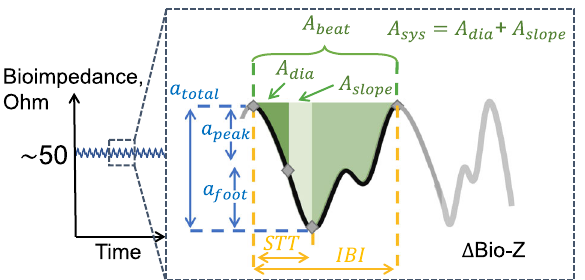
Fig. 4 Bioimpedance signal illustration during a cardiac cycle and the corresponding bioimpedance feature de fi nitions used in blood pressure correlation analysis. The amplitude features are shown in blue color, the timing features are shown in yellow color (STT: slope transit time, IBI: inter-beat intervals), and the area features are shown in green color. We named the feature pertaining to the area between the diastolic point and the maximum slope point as A dia , the area between the maximum slope point and the systolic point as A slope , and the area between the diastolic and the systolic point as A sys performance, and to avoid additional burden on the participants), while all fi ve participants underwent the test involving different separations. During the experiments, the participants were asked to remain still with their left hand resting on a table, as shown in Fig. 3d. For each ring setup a total of fi ve 30-second trials were conducted and the data is post-processed in MATLAB R2019b for sensitivity and signal fi delity analyses. To assess the ring sensor sensitivity to digital artery blood fl ow, we analyzed the quasi-periodic bioimpedance signal with a characteristic morphology, as: (i) an impedance decrease from diastolic peak to systolic bottom with the increase in blood volume during systole, (ii) followed by an increase in the impedance as the blood volume leaves the sensing area, (iii) the second impedance decrease due the arrival of the re fl ection wave, (iv) a fi nal increase in the impedance as the re fl ected blood volume leaves the sensing area, as shown in Fig. 4. As the participants were at rest, for every heartbeat we expect the morphology de fi ned with the steps (i) to (iv) to change minimally, where any deviations are hypothesized to be the artifacts. We initially normalized the time scale for each beat using the individual inter-beat intervals (IBI) to provide a fair comparison of morphological deviations under varying heart rates. We quanti fi ed the amount of deviation in beat-to-beat bioimpedance morphol- ogy using three different metrics: (1) standard deviation (SD) from the mean waveform morphology, (2) signal-to-noise ratio (SNR) from the fundamental heart rate frequency to the noise fl oor measured through the Fast Fourier Transform (FFT) of the full 30- seconds cycle, and (3) dynamic time warping (DTW) distance of waveforms to the mean waveform morphology for every beat (see Methods). We chose DTW distance as a metric to measure waveform similarities instead of Euclidean distance to account for morphological changes in waveforms from beat-to-beat due to the physiological reasons (e.g., blood fl ow rate impacting the timing of step (iii) – re fl ection wave arrival) 28 . Figure 5a provides an example for the ensembled bioimpedance beats for different ring separations and con fi gurations with signals acquired from the same participant, where smaller ring electrode separation of Con fi guration 1 shows a more consistent waveform pattern compared to the case of higher separation or different con fi gura- tions of injection and sensing electrode connections.